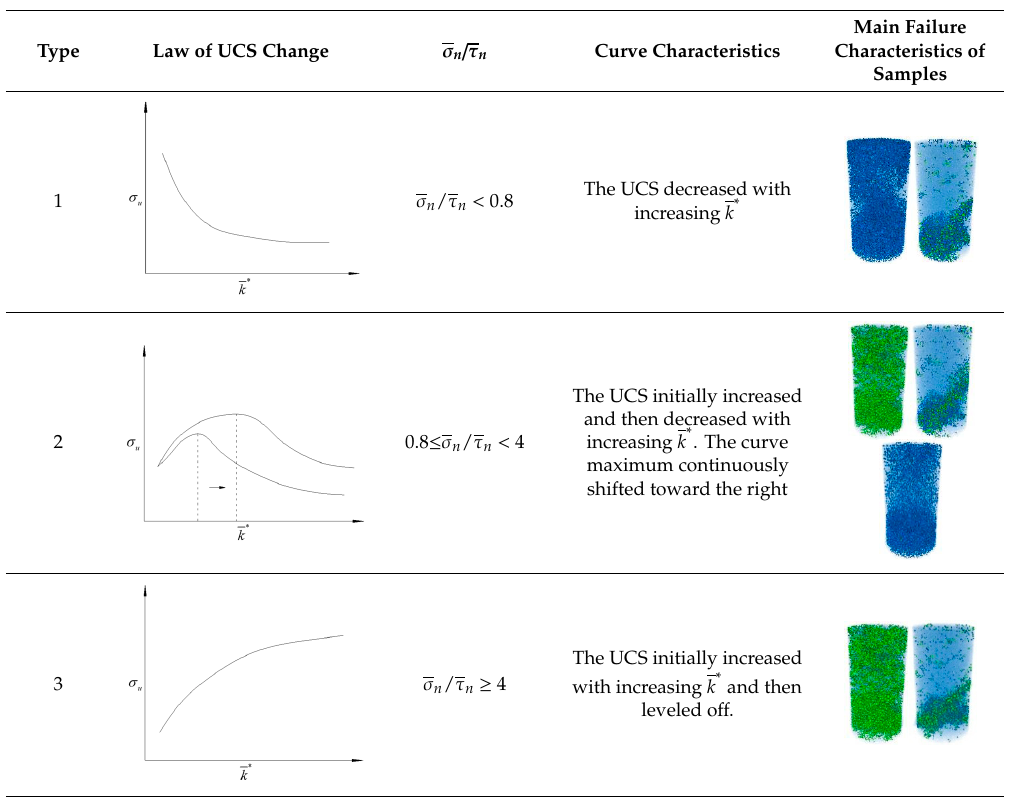
Table 4. Effect characteristics of bond normal-to-shear stress ratio ( σ n / τ n ) and parallel-bond stiffness ratio ( k ) on the macro-properties.